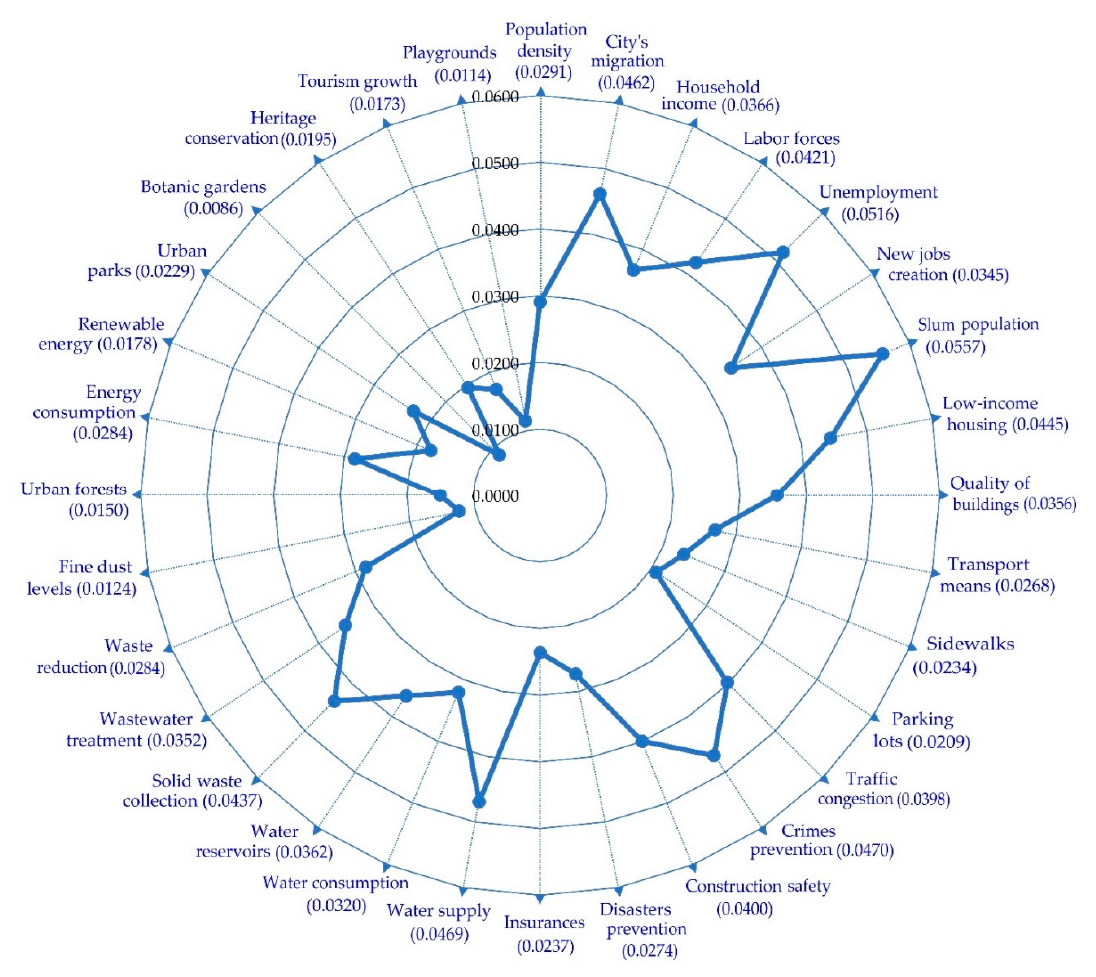
Figure 15. Relative weights of the 32 assessment indicators.